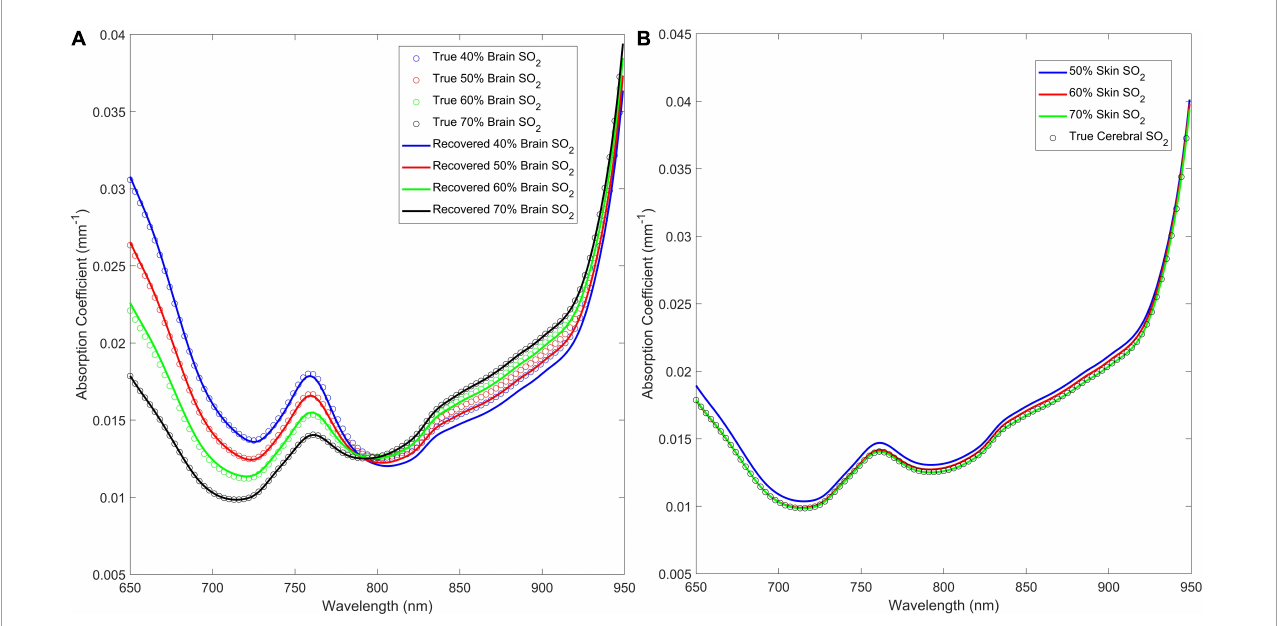
FIGURE5 Results from Phase 1 with unknown (A) and known (B) ECL thickness and Phase 2 (C) : For every cerebral oxygen saturation, 11 scalp saturations (50 to 70 in 2% increments) were evaluated. The estimated oxyhemoglobin (red), deoxyhemoglobin (blue), and total hemoglobin (black) are plotted against the true cerebral SO2. The dotted lines are the “ground truth” while the solid lines are the estimated values. The error bars represent the standard deviation.